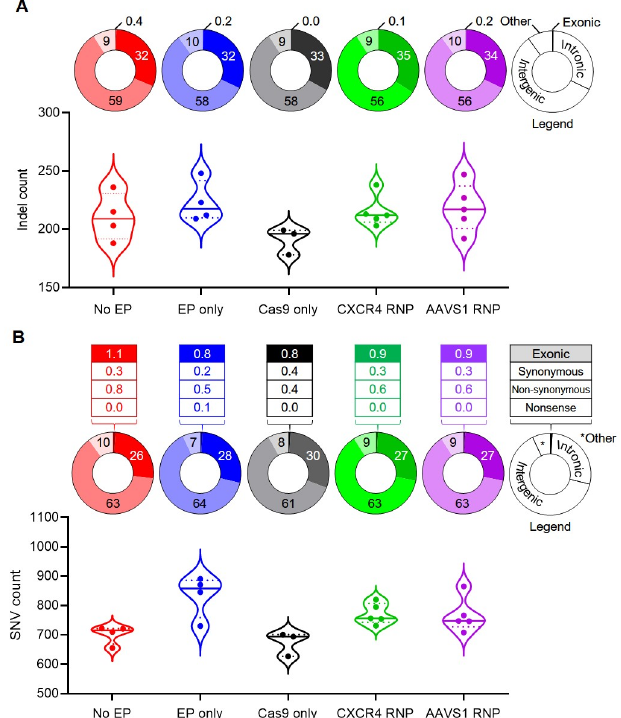
Figure 3. Characterization of non-targeted indels and single nucleotide variants (SNVs). ( A ) The frequency of non-targeted indels is plotted for each treatment group ( n = 3 to 5). The percentage of non-targeted indels observed within exons, introns, intergenic regions, and other genomic features (e.g., 5 ′ UTRs, 3 ′ UTRs, splicing signals, and ncRNAs) for each treatment group is indicated by a donut plot above each group. A nonparametric Kruskal–Wallis test found no statistical difference in the mean indel count among the treatment groups ( p = 0.1730). ( B ) The frequency of SNVs for each data set is plotted ( n = 3 to 5). The percentage of SNVs mapping within exons, introns, intergenic regions, and other genomic features (e.g., 5 ′ UTRs, 3 ′ UTRs, splicing signals, and ncRNAs) is indicated by a donut plot above each group. Kruskal–Wallis analysis indicated a statistically significant difference among the treatment groups ( p = 0.0093). Dunn’s multiple comparison test comparing each treatment group to the “No EP” baseline control indicated that the “EP only” group demonstrated a weak statistical difference in number of total SNVs ( p = 0.0414). A p- value less than 0.05 was considered statistically significant.